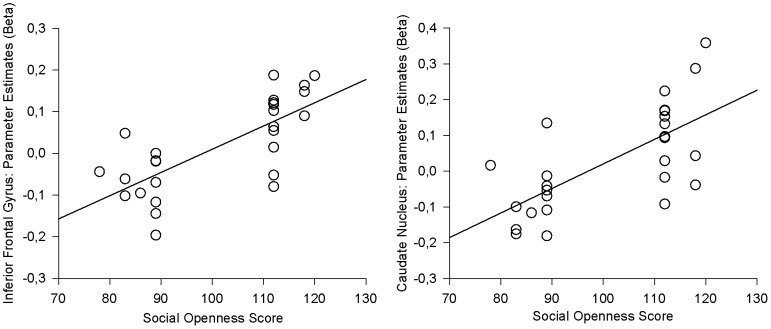
Individual beta values of peak activation plotted against social openness scores.Left paragraph: Peak activation within the inferior frontal gyrus vs. social openness scores; right paragraph: Peak activation within the caudate nucleus vs. social openness scores.